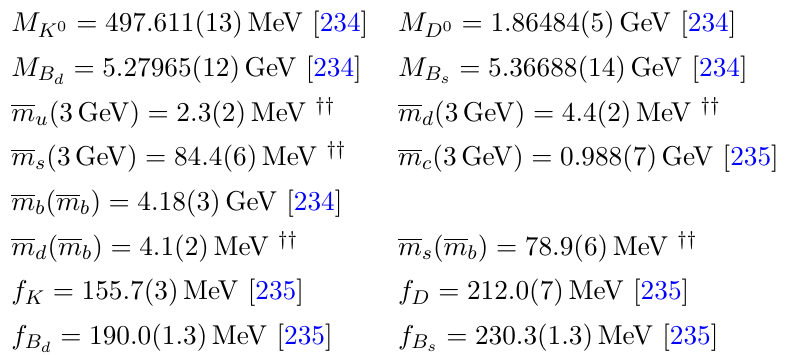
Table 3 . Set of inputs used in the numerical analysis. The inputs marked †† have been obtained from the values at the scale of 2 GeV given in ref. [235], by running them to 3 GeV and 4 . 18 GeV using RunDec [237] at four loops in 4-flavour